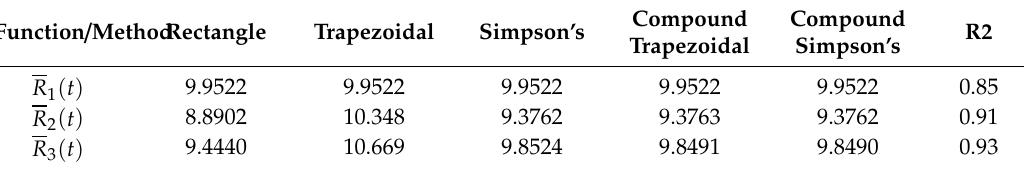
Figure 5. Source code of the numerical integration software. Table 3. Results obtained with subsequent